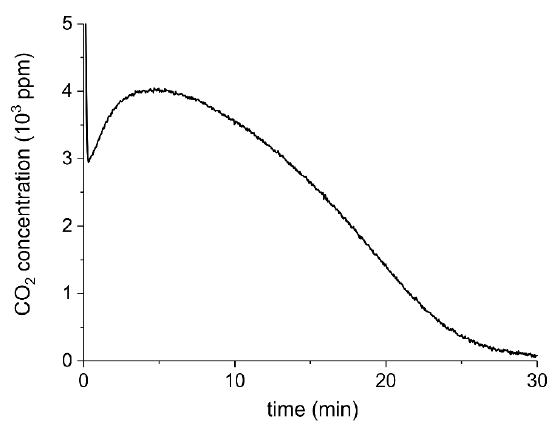
Figure A11. Concentration of CO 2 during CaCO 3 decomposition (sample C) as function of time at 680 °C and a flow rate of 30 mL/min.